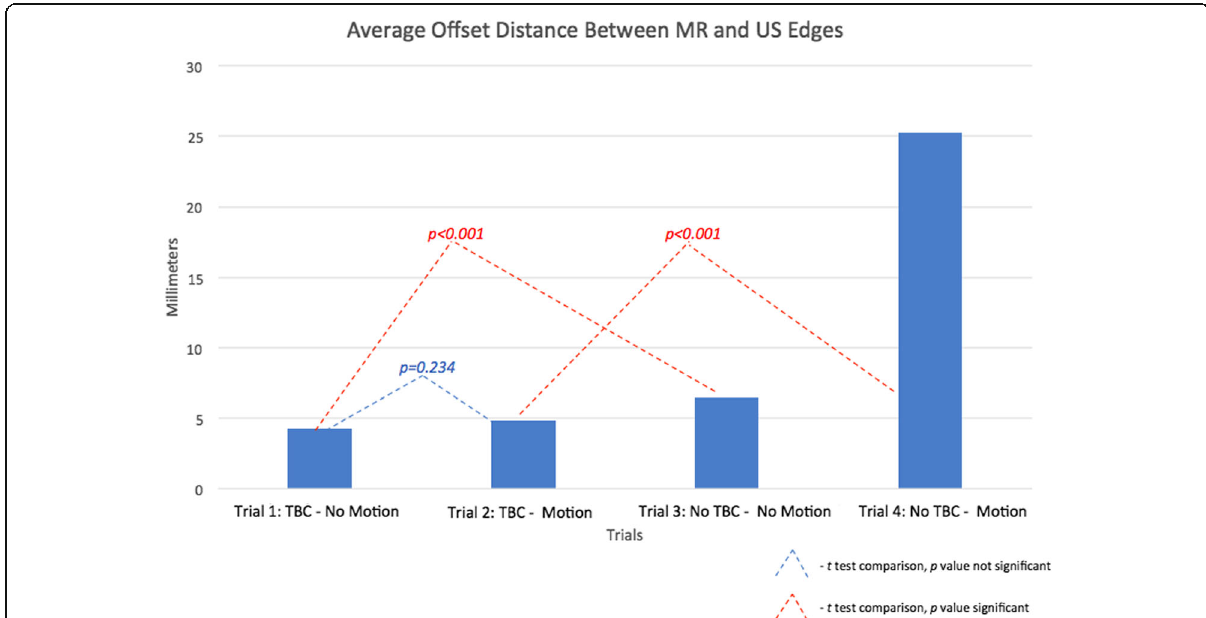
Fig. 8 Average offset distance (OD) and comparison of results for trials 1 to 4. OD was defined as the distance between the phantom edge on ultrasound and perpendicular line striking the same location as seen on the contoured edge on magnetic resonance imaging on fusion images. Trials vary the presence/absence of the TFC and motion (see